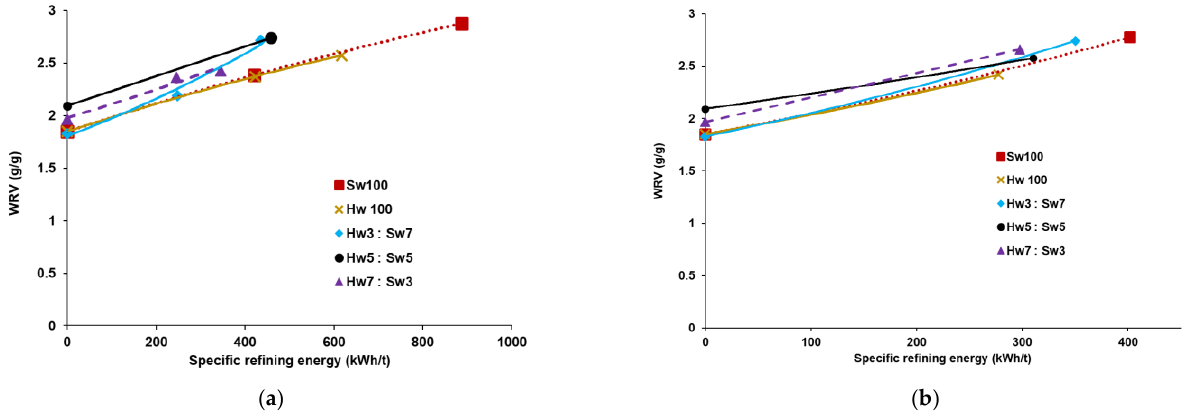
Figure 8. Effect of CEL on mean fiber length and fines content of the mixed pulps: ( a ) PA55; ( b )